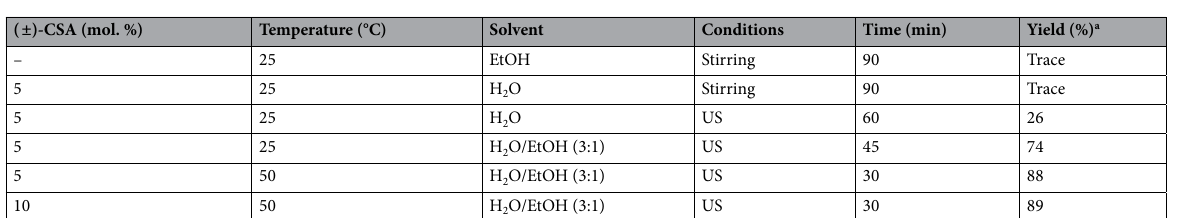
Table 1. Optimization of ( ±)-CSA catalyst loading in the synthesis of compound